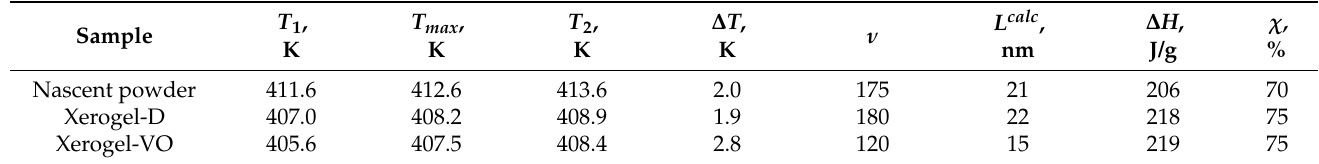
Table 1. Thermodynamic parameters of the melting peak of the samples of UHMWPE nascent powder and two xerogels (in decalin and vaseline